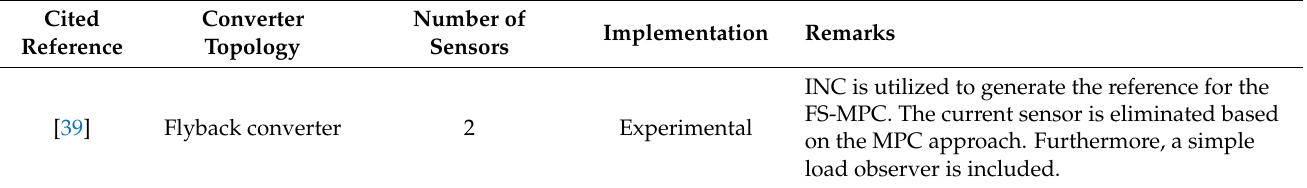
Table 2. Sensor reduction approaches for MPPT-based